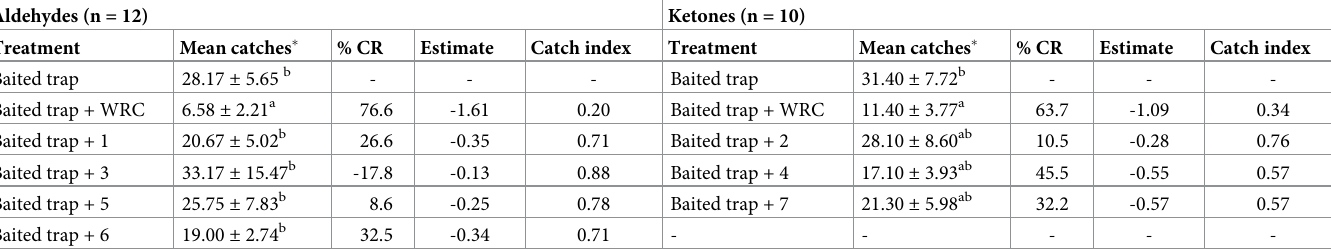
Table 2. Mean catches ( ± SEM) and estimated catch indices of pooled males and females G . pallidipes in cow urine and acetone-baited Ngu traps combined with individual compounds. Aldehydes (n = 12) Ketones (n = 10) Treatment Mean catches �